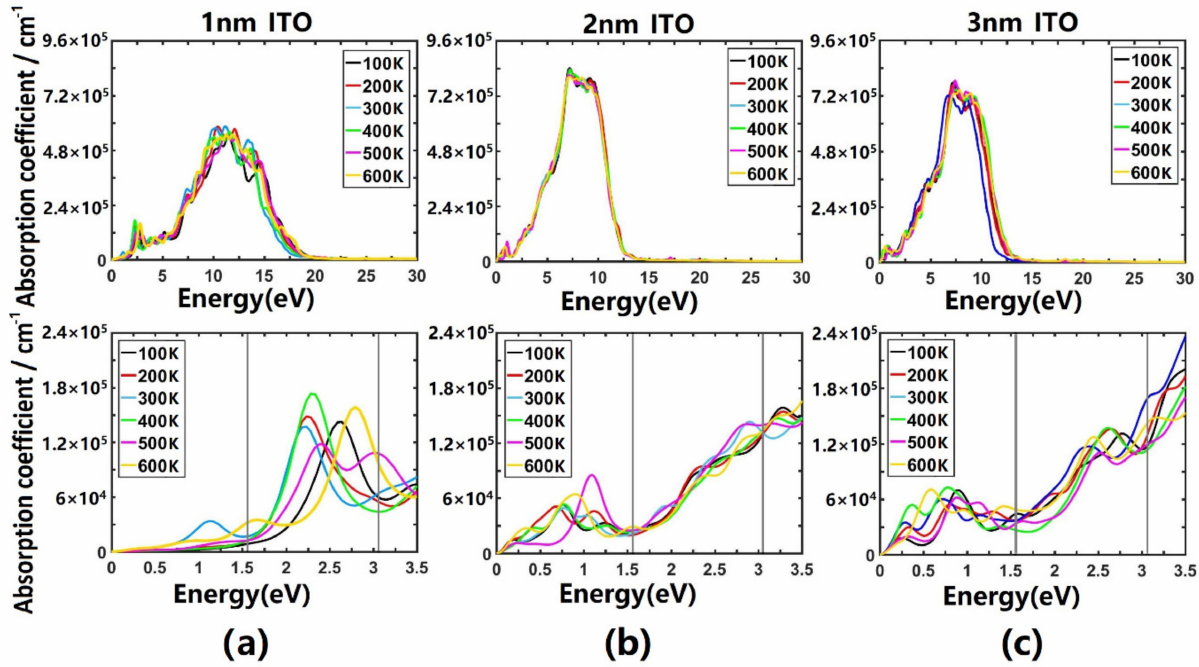
Figure 6. Absorption coefficient (in cm − 1 ) spectra of 1 ( a ), 2 ( b ), and 3 ( c ) nm ITO models at temperatures ranging from 100 to 600 K. Upper panel shows the spectra in the energy range between 0 and 30 eV. The lower panel highlights the region near the visible light zone bounded by two gray dashes (energy varies from 1.63 to 3.11